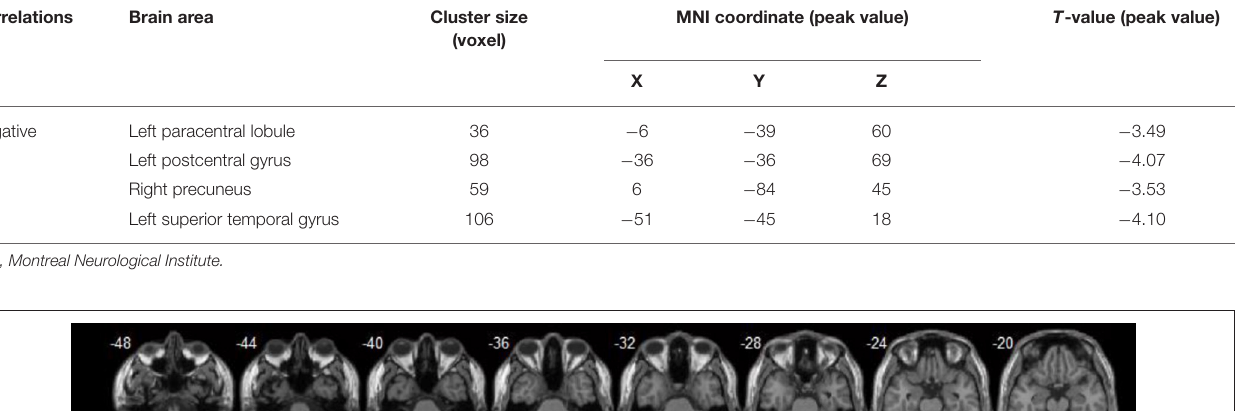
TABLE 4 | Correlations of ReHo values between brain areas and HAMA. Correlations